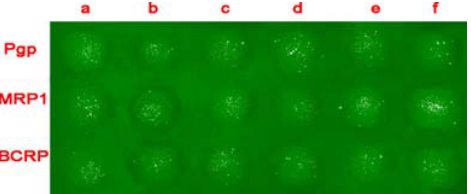
Figure 1. The relapsed-refractory AL patients’ cells combine antibodies onto the agarose film modified glass.